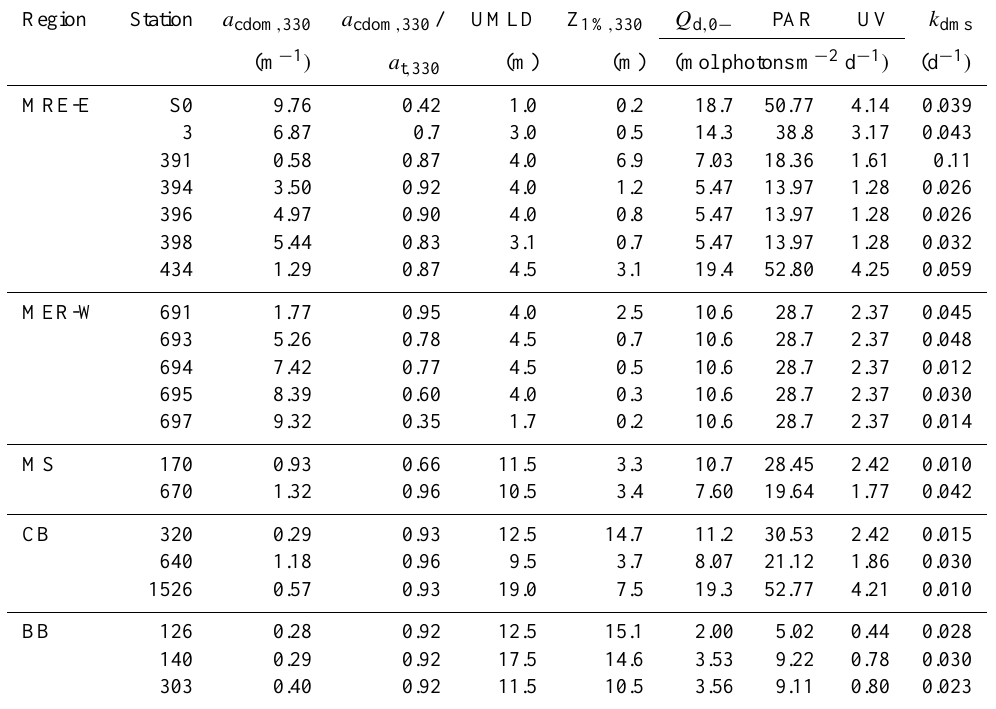
Table 3. Photochemical DMS turnover rate constants ( k dms ) and the corresponding a cdom , 330 / a t , 330 ratios, upper mixed layer depths (UMLD), 1% penetration depths for radiation at 330nm (Z 1% , 330 ) , integrated photon fluxes of PAR (400–700nm), UV (290–400nm) and downwelling solar radiation (290–500nm) just below the sea surface ( Q d , 0 − ) . Absorption coefficients for CFL stations (Sta. S0, 3, and 434) were not measured. The a cdom , 330 / a t , 330 ratios for Sta. S0 and 3 were estimated from the best fit of the a cdom , 330 / a t , 330 ratio to salinity covering data with salinity ≤ 23.5 ( Y = 0.025 X + 0.42, R 2 = 0.922, n = 10). The a cdom , 330 / a t , 330 ratio for Sta. 434 was assumed equal to that for Sta. 391 based on their similar salinities (see Table 1). Absorption data for Baffin Bay (Sta. 126, 140, and 303) were obtained from Bélanger et al. (2008). Station 1526 refers to surface water (5m) only. Keys for the “Region” column are the same as in Table